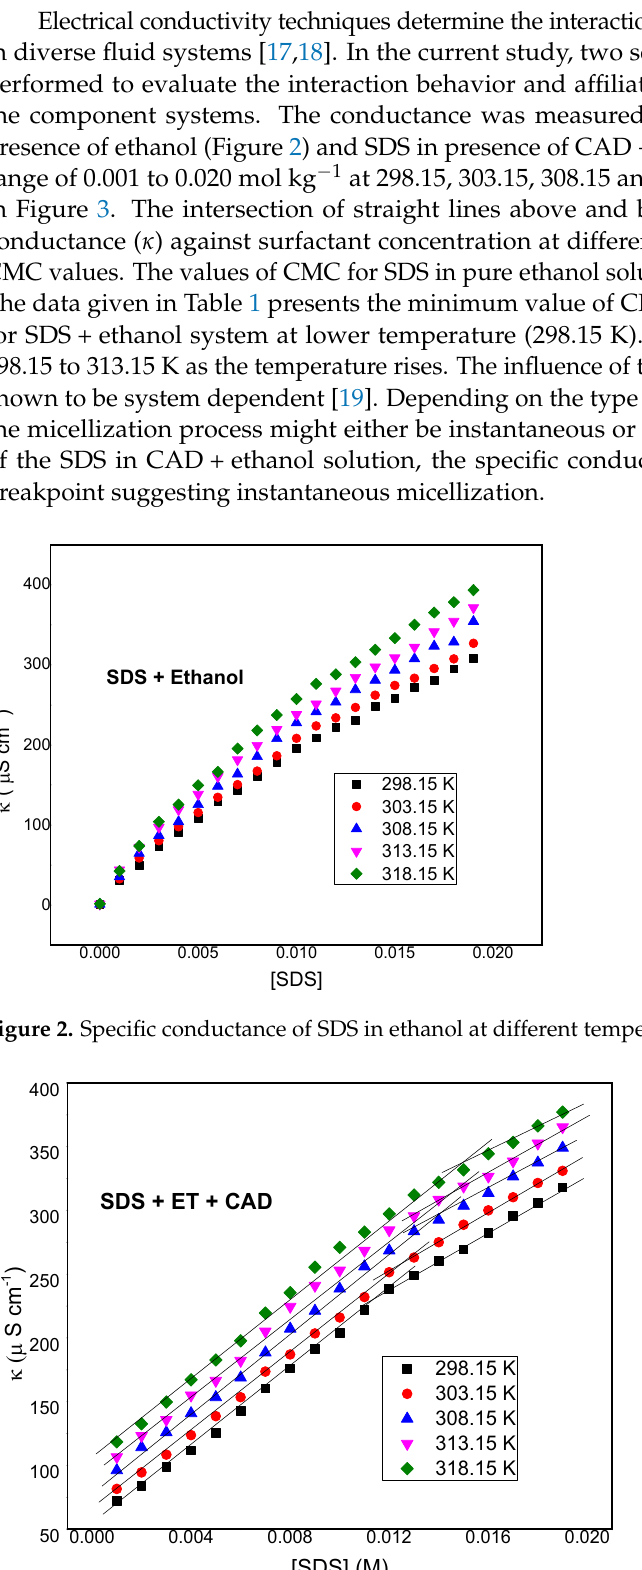
tem, and the micellization process observed is different. CAD molecules are insoluble in Figure 3. Specific conductance of SDS in cinnamaldehyde + ethanol at different temperatures .